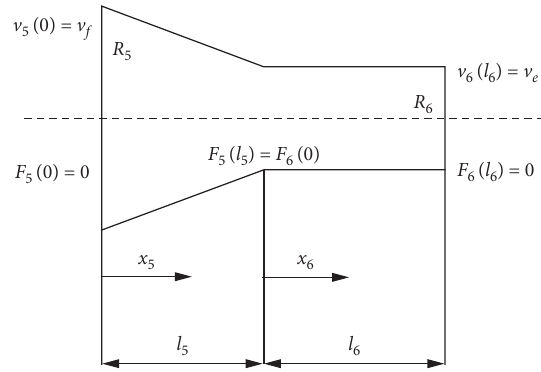
Figure 4: Stepped conical compound